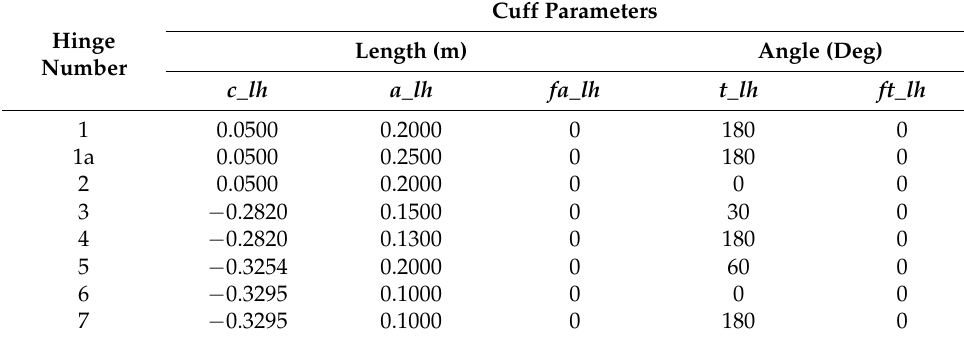
Figure 5. Conceptual configuration of C-LREX with 4 cables case (II) routing. Numbers denote hinges for the cable attachment. Table 3. Cable hinges parameters.